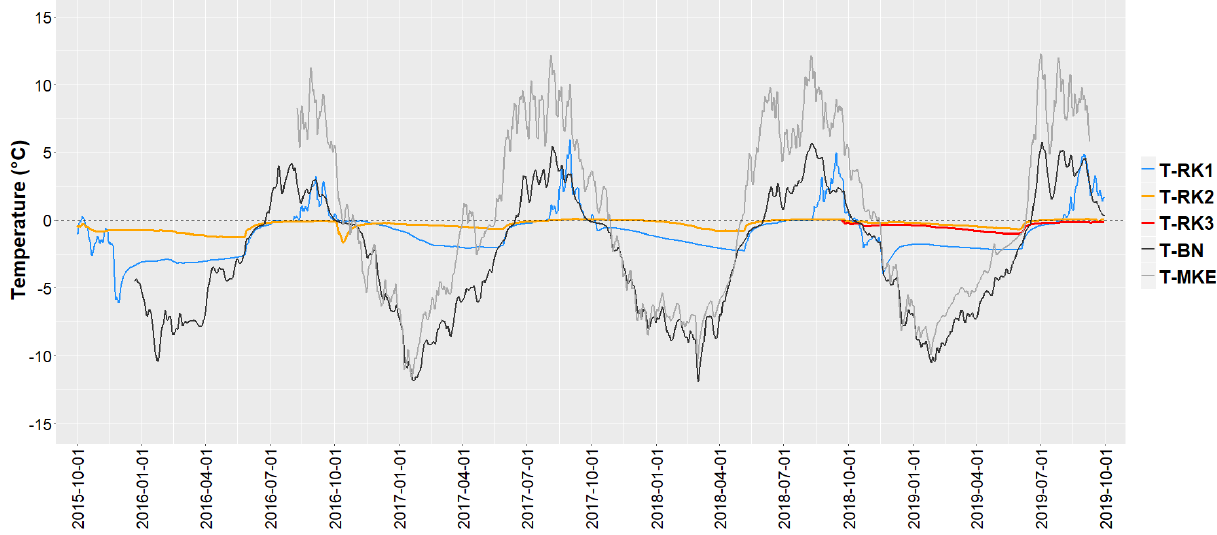
Figure 15. Near-surface bedrock temperature for five measurement sites located at KN and MKE. Perennially frozen, near-isothermal conditions observed inside the randkluft (T-RK2, T-RK3) contrast with large seasonal amplitudes in the open rockwall. All temperatures were measured at 0.8m borehole depth (1.0m at T-BN). Table 3. Annual mean, minimum and maximum near-surface bedrock temperature for five measurement sites at KN and